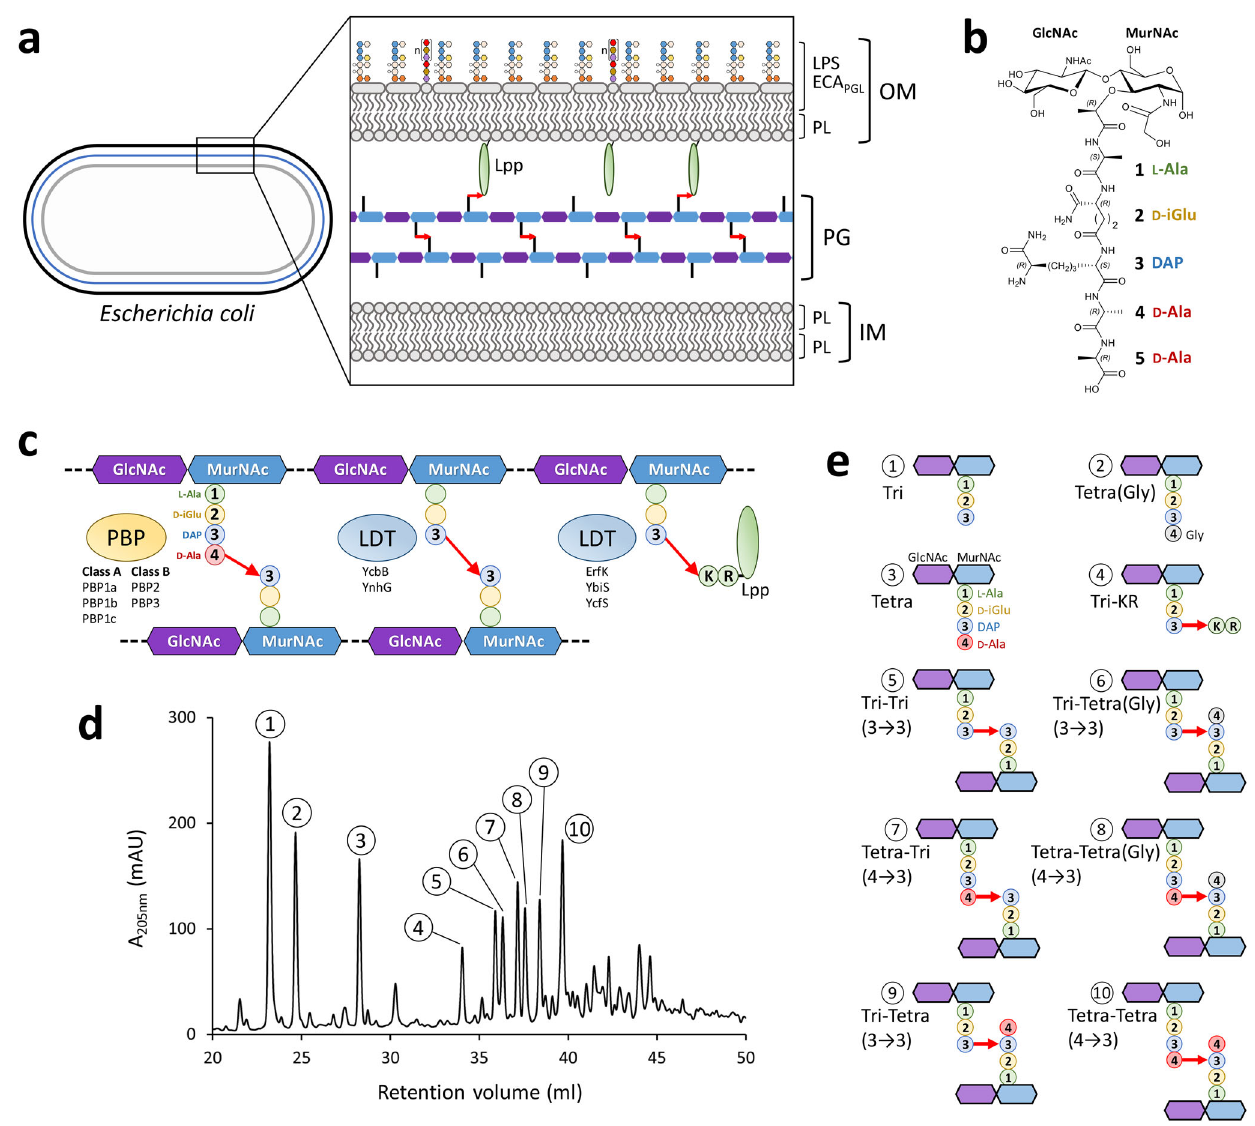
Fig. 1 | Structure of the multilayered E. coli envelope. a The envelope is com- posed of inner (IM, gray) and outer (OM, black) membranes. Peptidoglycan (PG, blue) ensures osmotic protection of the bacterial cell. The IM is a lipid bilayer composed mainly of phospholipids (PL). The OM is an asymmetric lipid bilayer: the inner lea fl et is composed of PL and the outer lea fl et of lipopolysaccharides (LPS) and phosphatidylglycerides substituted by the enterobacterial common antigen (ECA PGL ). b Structure of the PG subunit (GlcNAc, N -acetyl-glucosamine; MurNAc, N -acetyl-muramicacid). c PGisanet-likemacromoleculemadeofglycan chains (blue-purple polygons) cross-linked together by short peptide stems (colored circles). PBPs catalyze the formation of 4 → 3 cross-links connecting the